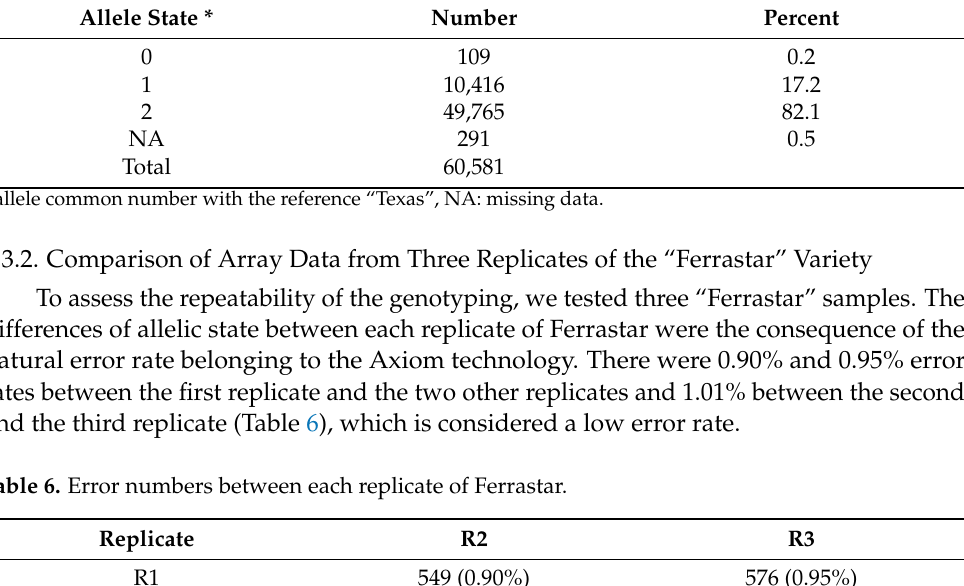
Table 5. Number of SNPs for each allelic state for the genotyped “Texas” accession. Allele State *